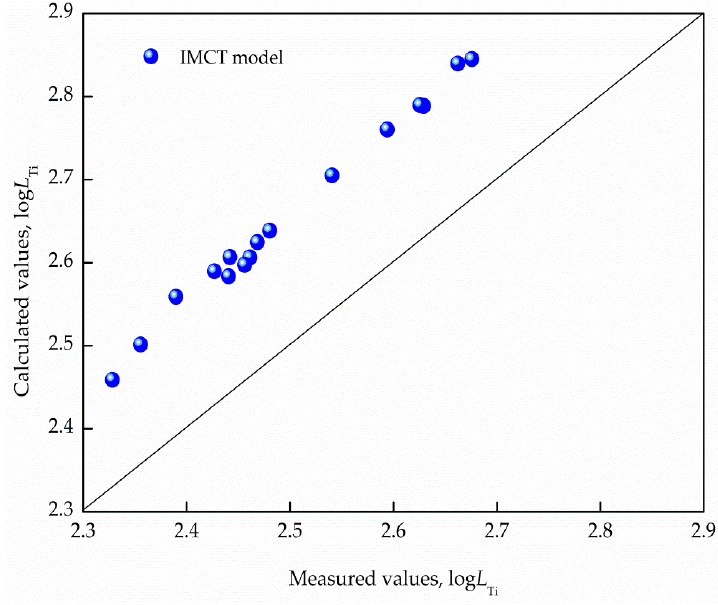
Figure 2. Comparisons between measured and calculated titanium distribution ratios